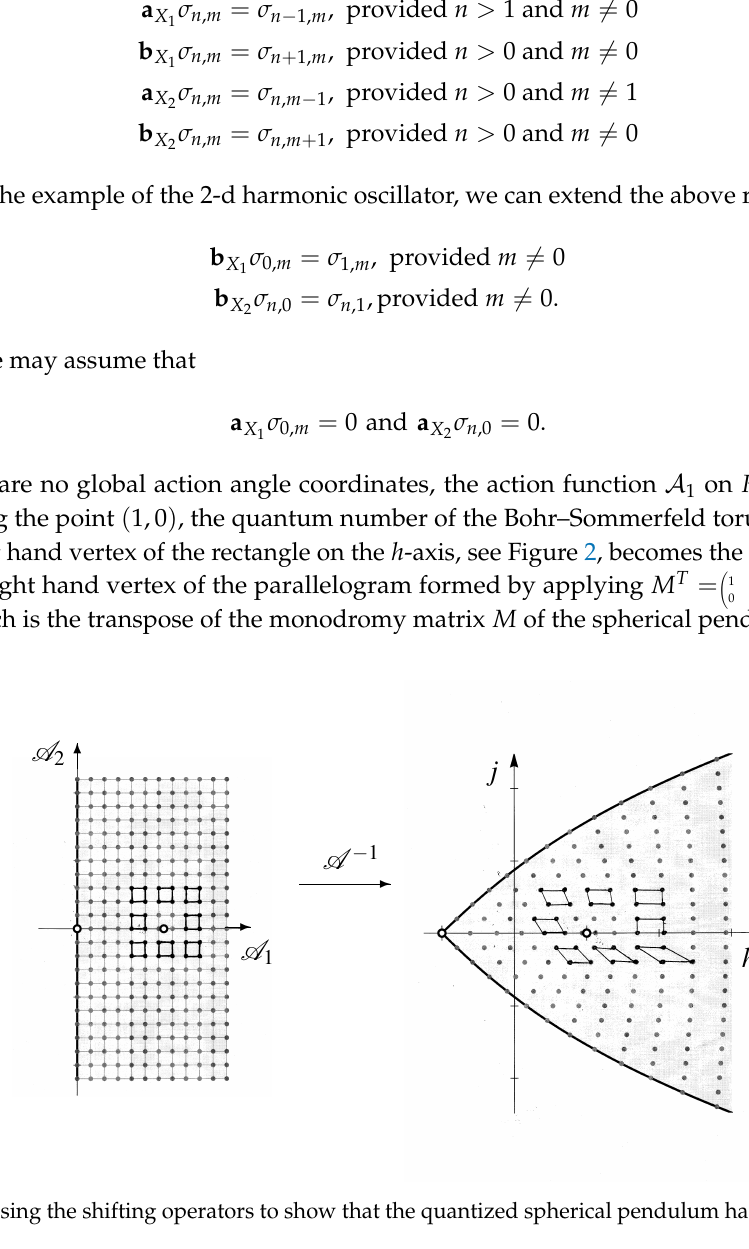
( P , ω ) with fibration ρ : P